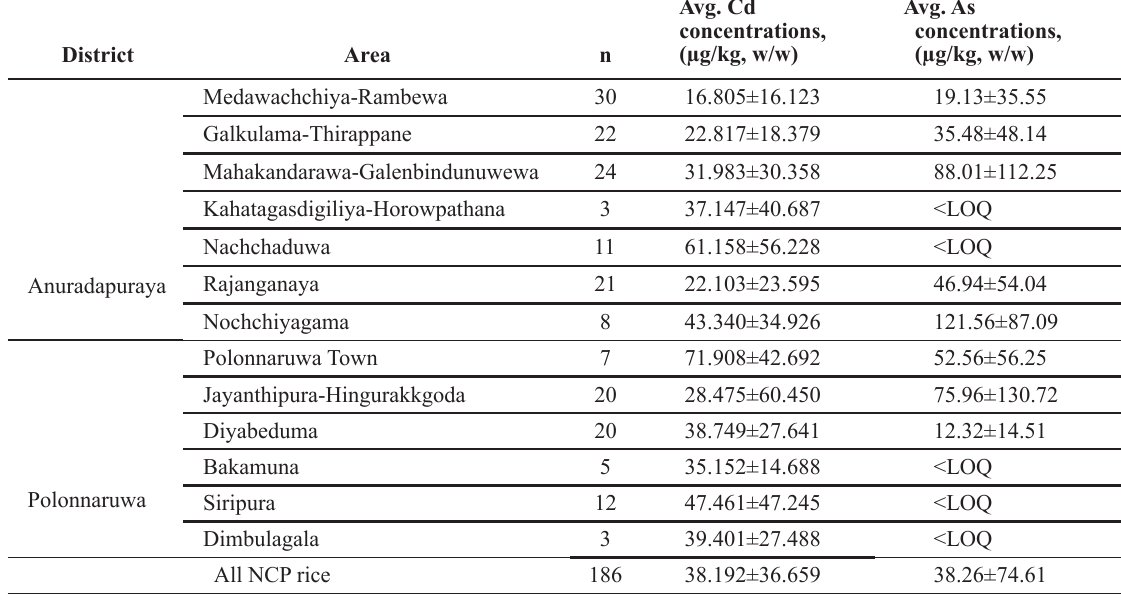
Avg. Cd Avg. As concentrations, concentrations, (µg/kg, w/w) (µg/kg,